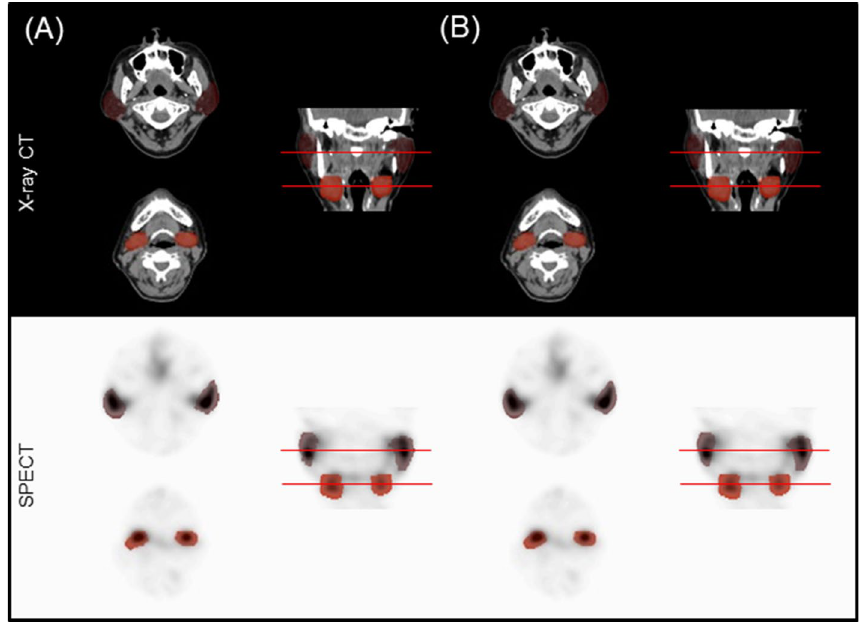
Figure 2. Salivary gland segmentation results. Representation of axial images, with the red bar in the coronal images indicating the ROIs for the parotid (upper image) and submandibular (lower image). ( a ) Manually segmented ROI. ( b ) Deep-learning-generated automatic ROI.